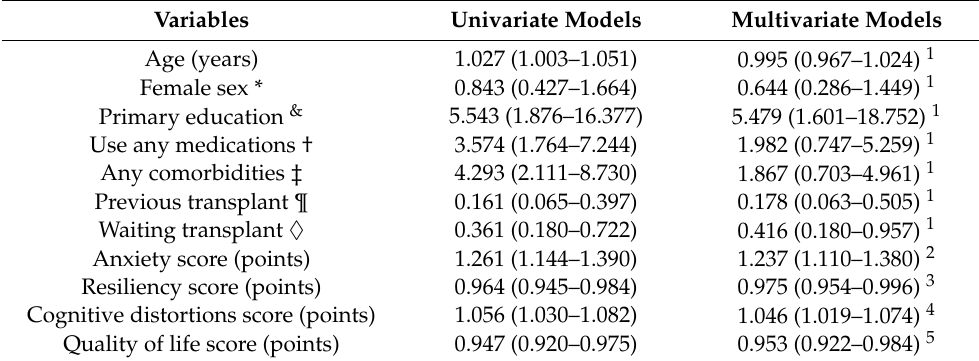
Table 4. Binary logistic regression analysis to assess the variables associated with the presence of depression (dependent variable). Results are shown as odds ratio